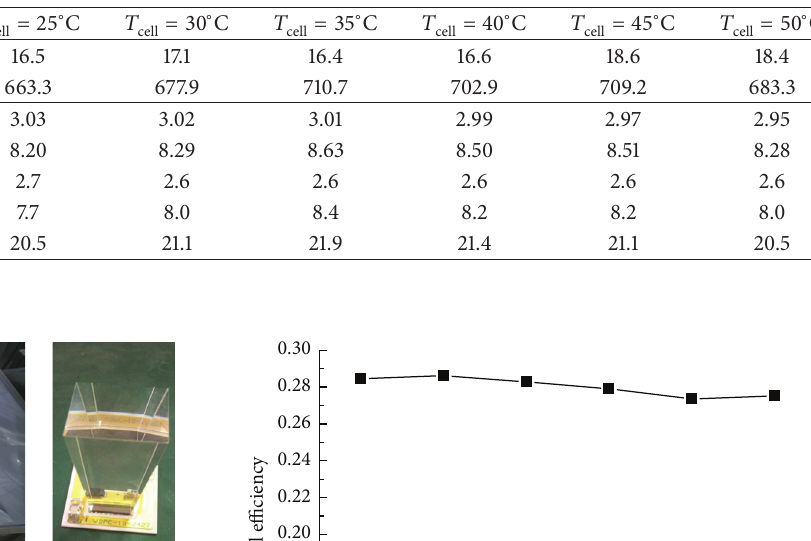
Table 4: Relative parameters at different PV temperatures.